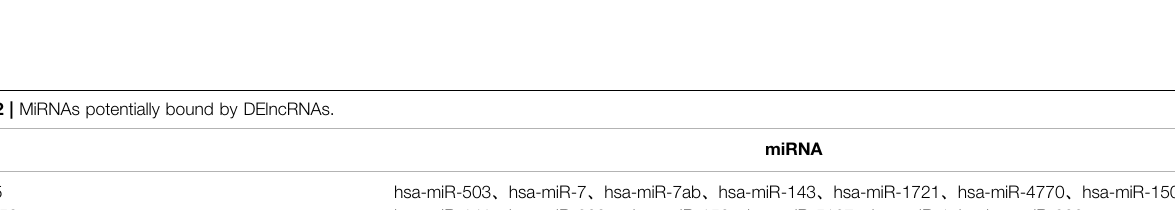
FIGURE 4 | Volcano plots: (A) LncRNA volcano plots. (B) mRNA volcano plots. Note: the vertical blue line corresponds to the increase and of log 2 FC, while the horizontal orange line indicates p value < 0.05. Red dots represent upregulated and statistically signi fi cant DElncRNAs, and green dots represent downregulated and statistically signi fi cant DElncRNAs. FC > 2.0 and p < 0.05 were used as standards, FC was log2 transformed, and the p value was − log10 transformed.